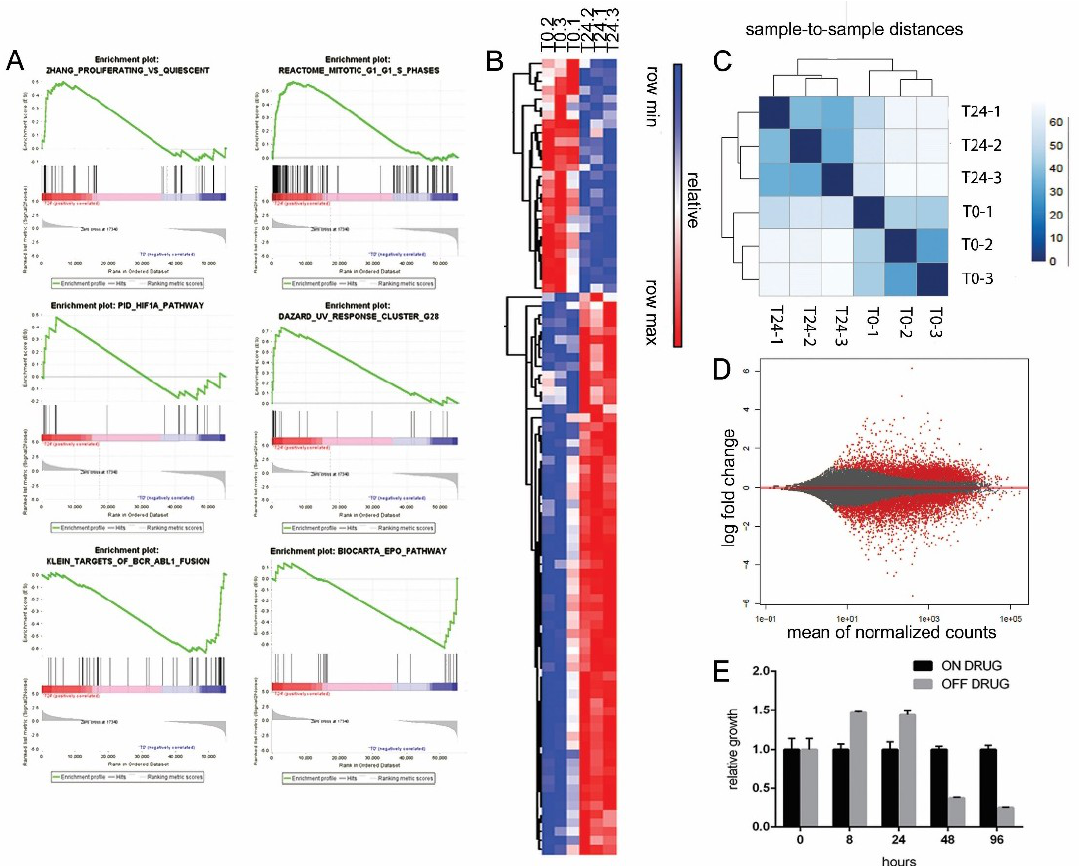
Figure 5. RNA sequencing was performed on LAMA-R cells, before and 24 h after drug withdrawal. Three independent experiments were analyzed. ( A ) Gene Sets Enrichment Analysis (GSEA). Six representative gene sets are shown. ( B ) heat map related to panel A gene sets. ( C ) Sample-to-sample distance matrix of Pearson correlation coefficients highlighting the high similarity of the three replicates. ( D ) MA plot showing the fold change as a function of average gene expression, before and after drug withdrawal. Differentially regulated genes reaching statistical significance are highlighted in red. ( E ) LAMA-R cells growth was assessed at the indicated time points after imatinib withdrawal (grey bars) and normalized on cells kept continuously on drug (black bars).